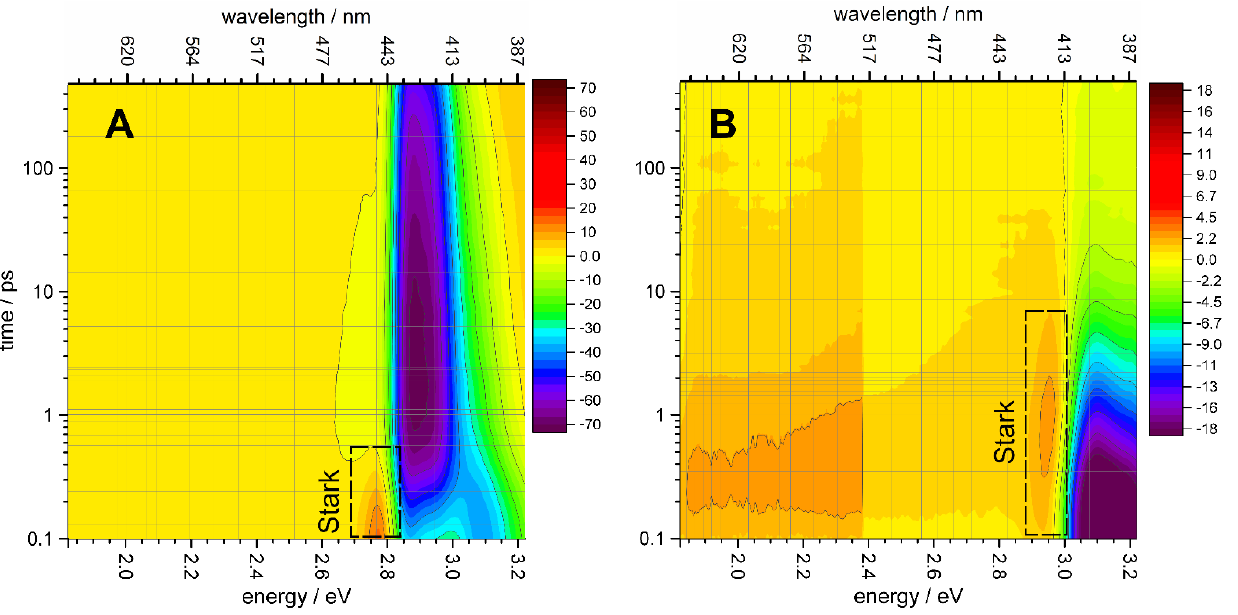
Figure 4. TA spectra of QD-1 ( A ) and QD-2 ( B ) samples in the form of the color map. TA signal in the range of ~1.95–2.35 eV (vertical black solid line is the border) is shown on the expanded scale with factor 3. ESA peaks corresponding to the Stark shift are indicated by dashed-line boxes.